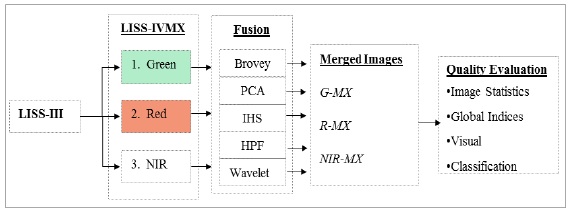
Fig-1: Steps involved in the data